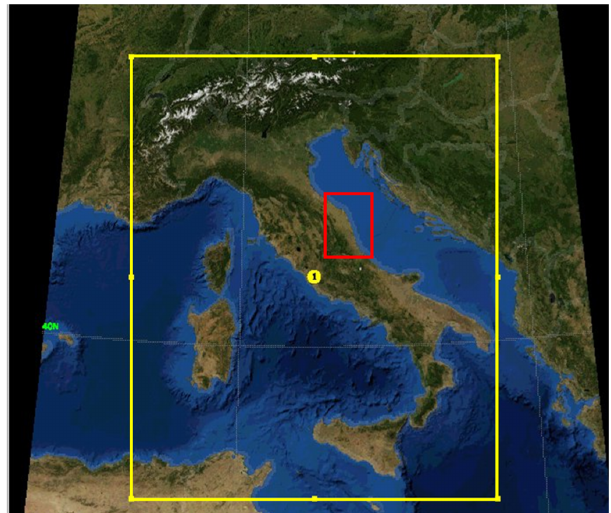
Figure 3. Domain for the WRF regional ensemble at 9km (yellow box). The red box indicates the area considered for the statical eval- uation covering the Marche and Abruzzo